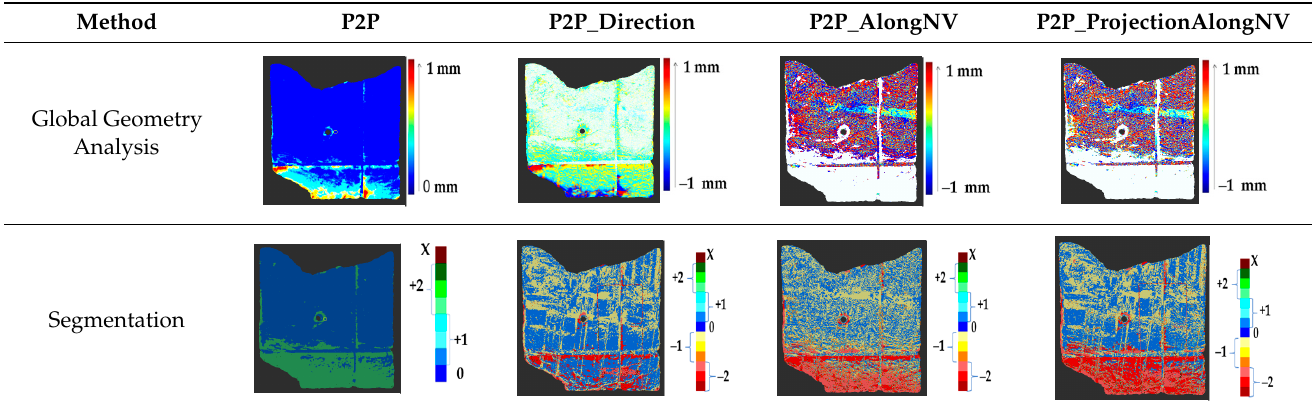
Table 19. Analysis and results for the dataset of NBL2.